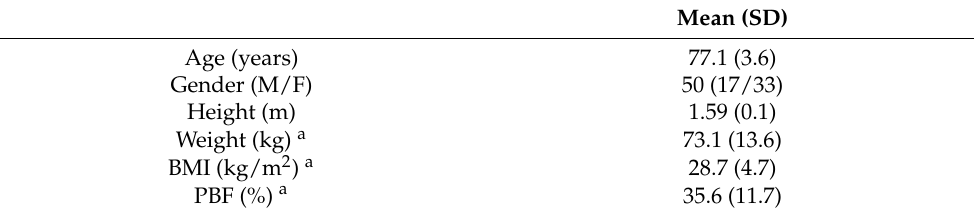
Table 1. Demographic data of participants included in the study.